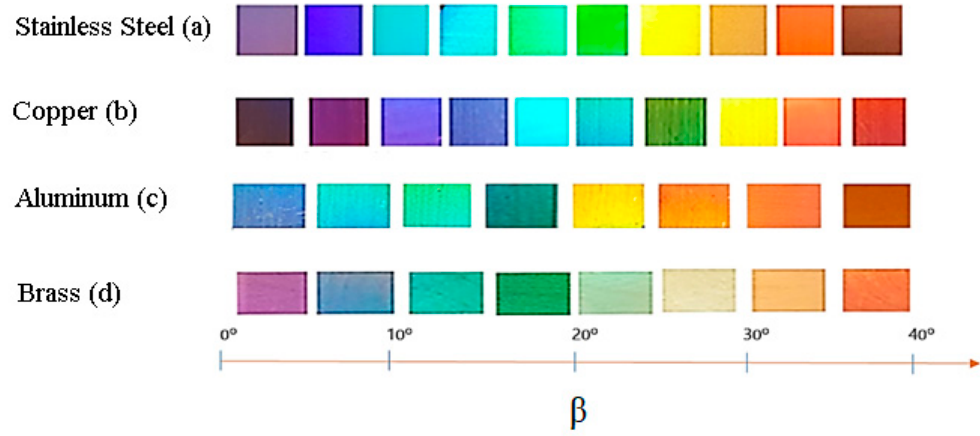
Figure 2. The color pallets taken from processed ( a ) stainless steel, ( b ) copper, ( c ) aluminum, and ( d ) brass by digital camera at different viewing angles. The scanning speeds for stainless steel, copper, aluminum, and brass were 350, 400, 500, and 450 mm/s, respectively. The fluence of the laser beam was 1.0 J/cm 2 . As β increased, colors shifted towards the longer wavelength region of the visible spectrum. The incident light angle was around 20 degrees.